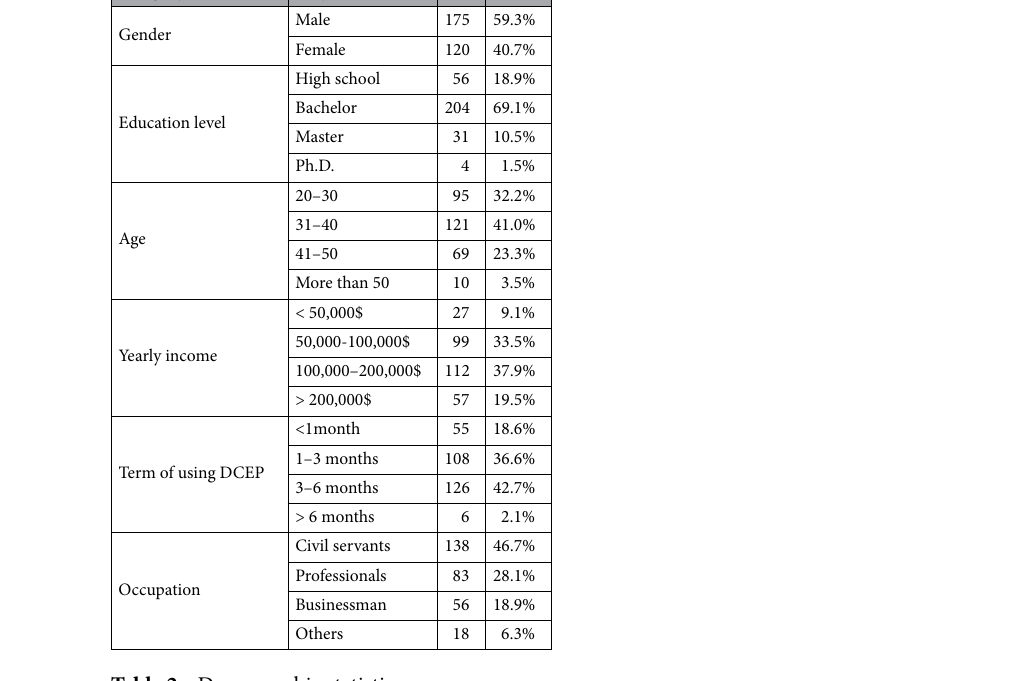
Table 2. Demographic